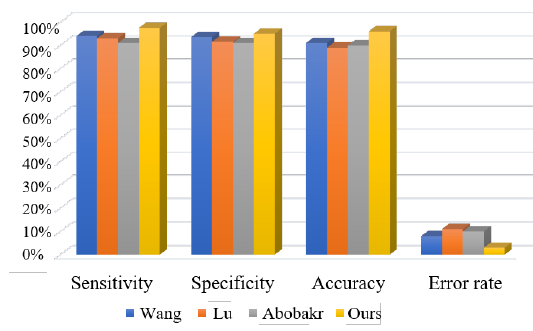
Fig. 6. Comparison of detection performance of different